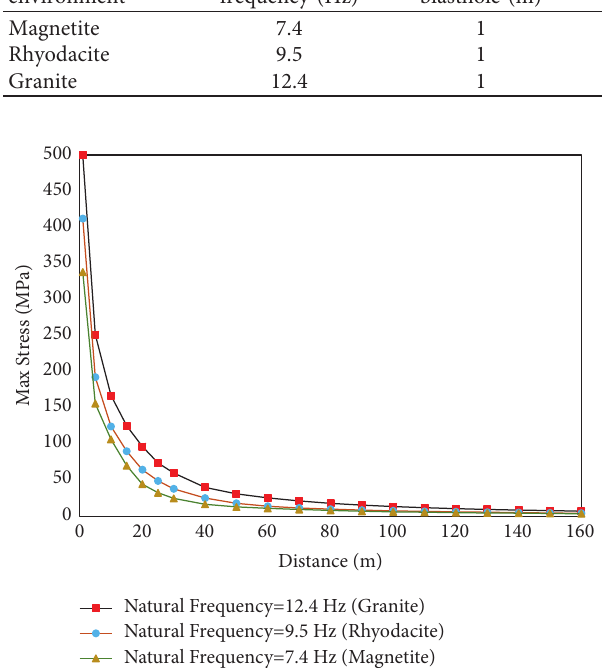
Table 4: Dominant vibration frequency variation at different distances from the blasthole with different natural frequencies. Geomaterial environment